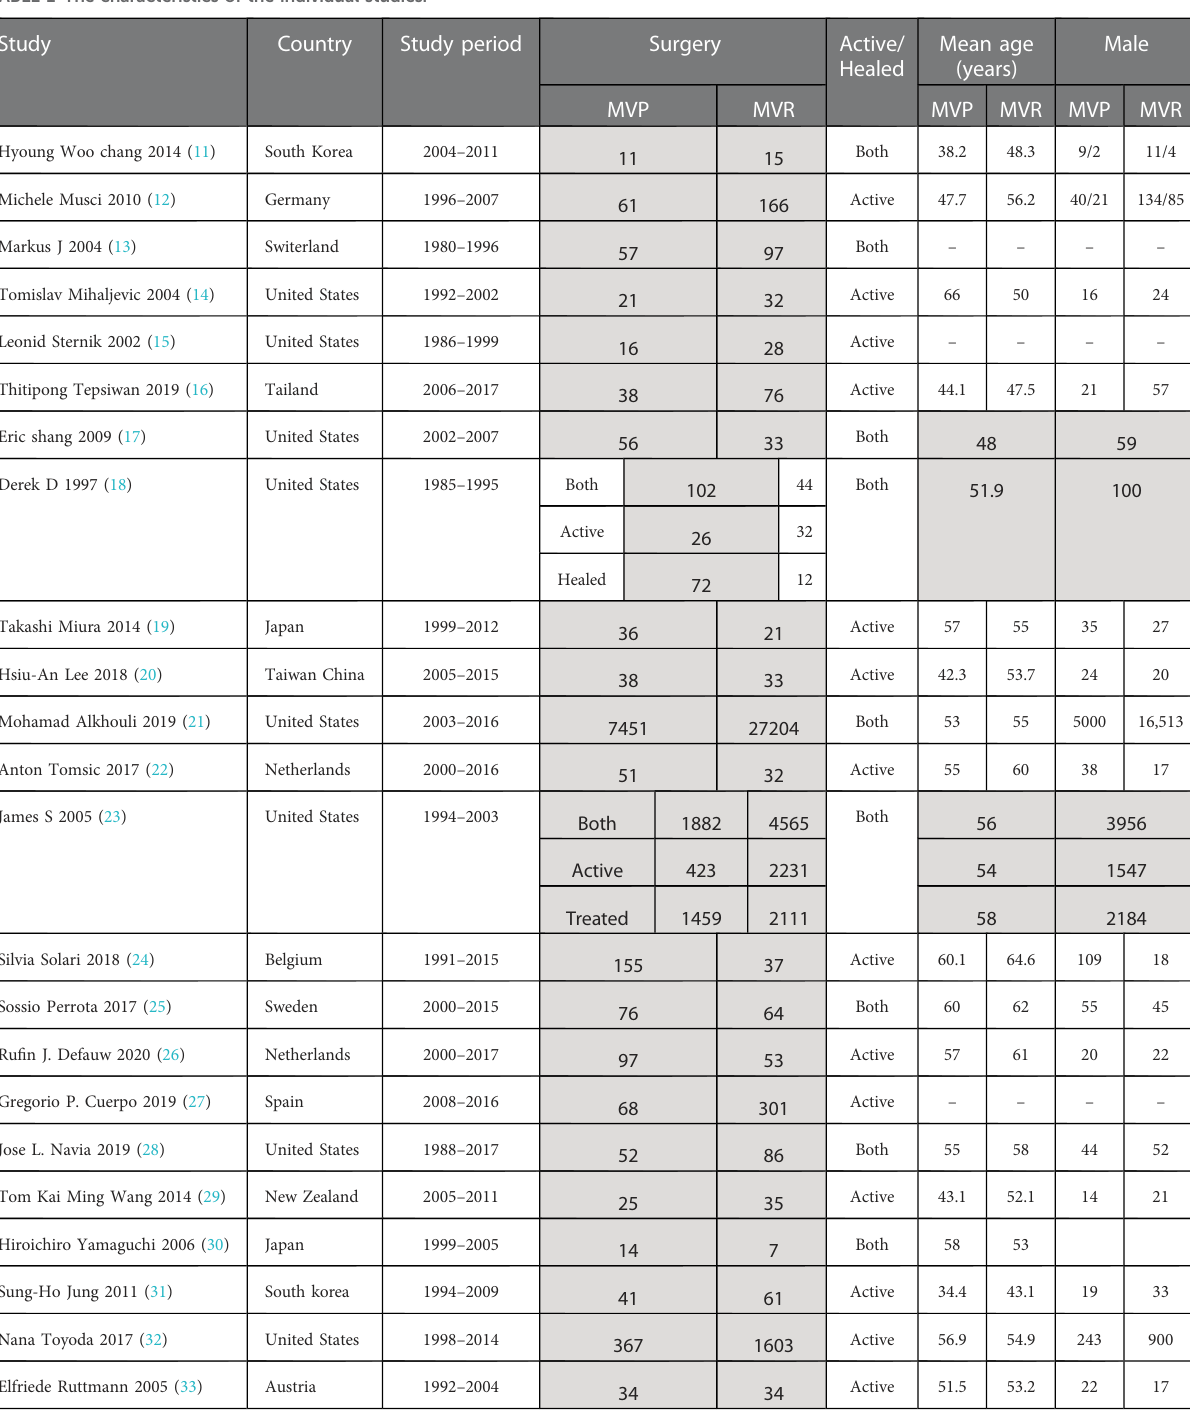
TABLE 1 The characteristics of the individual